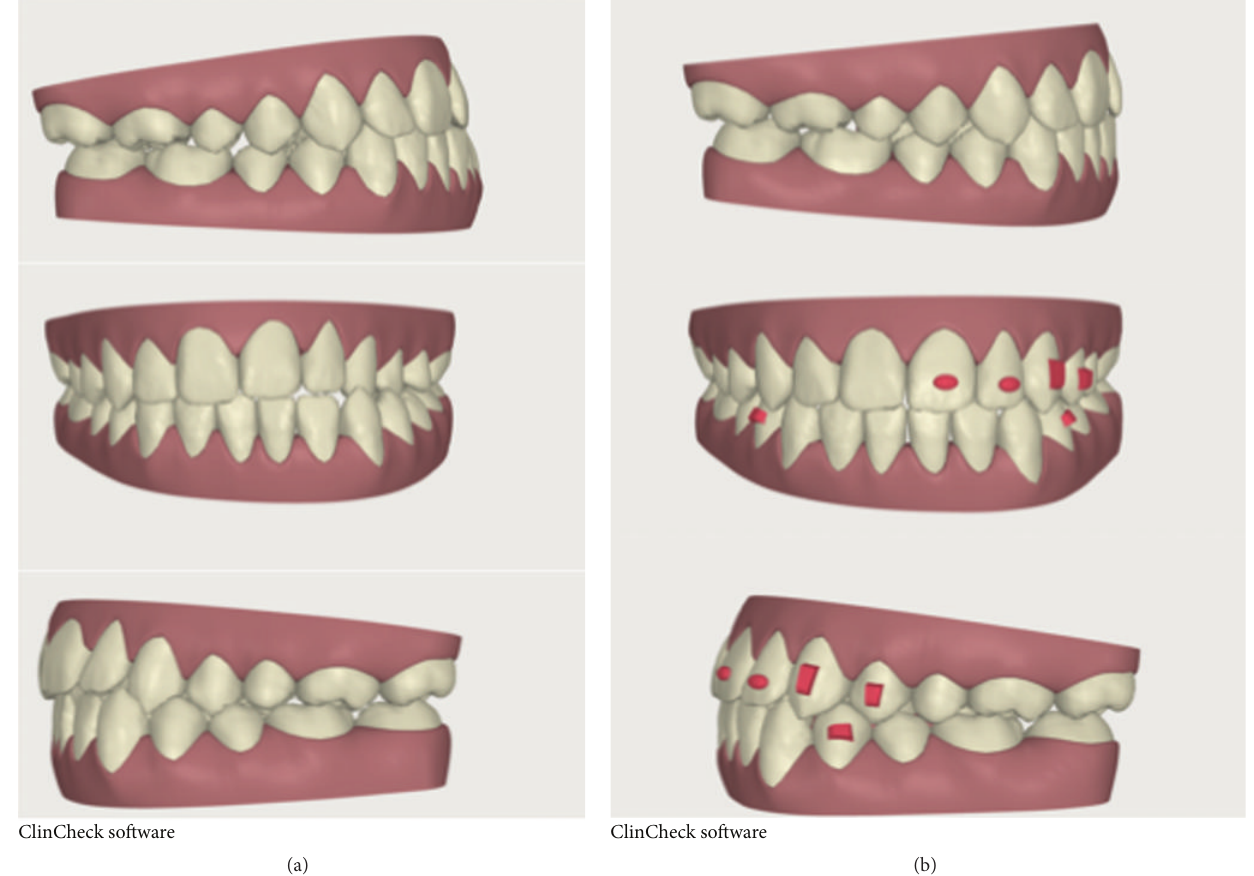
Figure 5: (a) ClinCheck pretreatment; (b) ClinCheck surgical